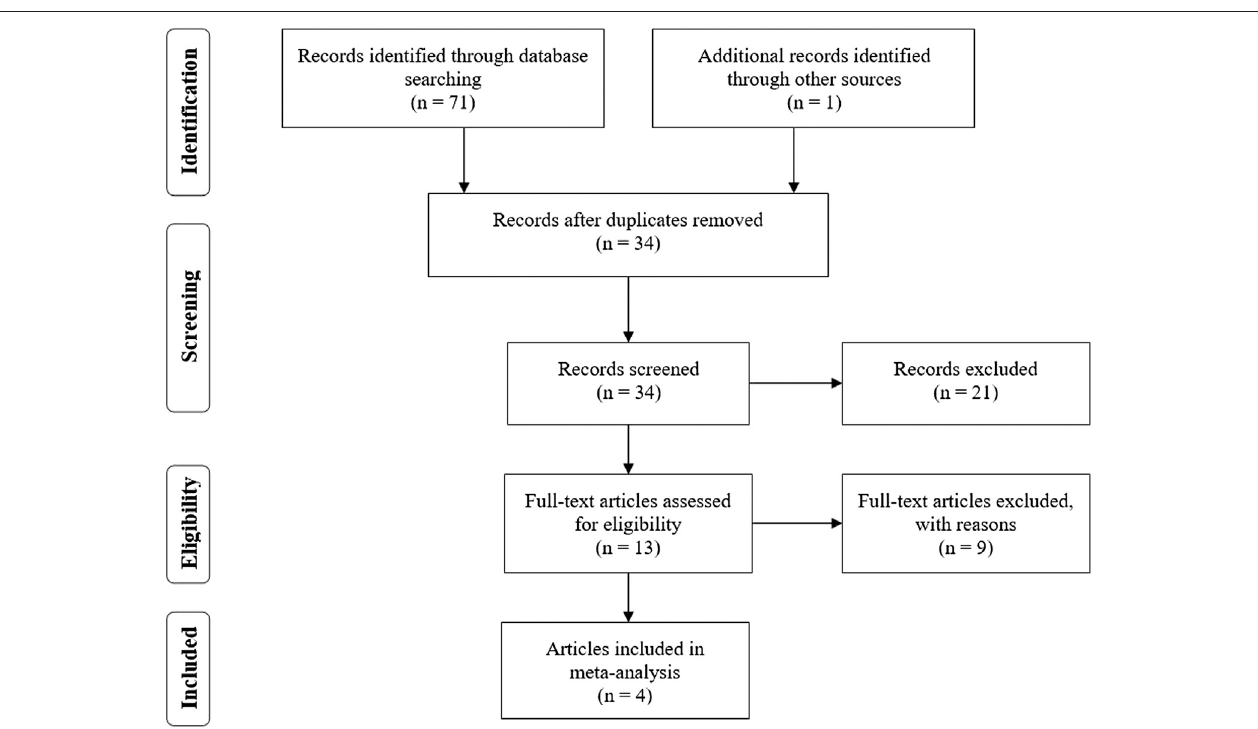
FIGURE 1 | The fl ow diagram of included and excluded